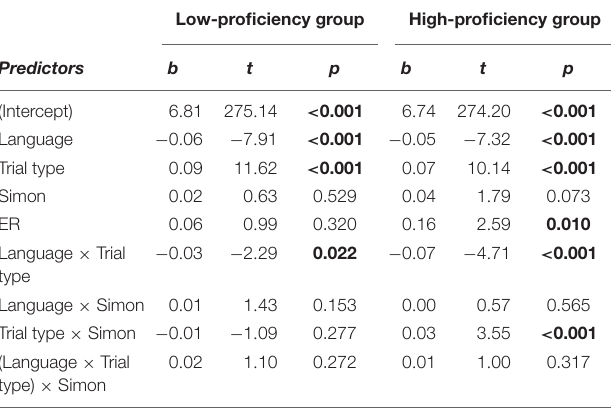
logRT, log-transformed response time; b, raw (unstandardized) regression coefficient; bold values denote statistical significance at the p < 0.05 level; ER, error rate; OPT, Oxford Placement Test. OPT and Simon scores were, respectively, centered at the sample mean. Language was contrast-coded with L1 as –0.5 and L2 as 0.5. Trial type was contrast-coded with non-switch as 0.5 and single- language as –0.5. Participants were grouped into high-and low-proficiency groups based on the median score of the Oxford Placement Test